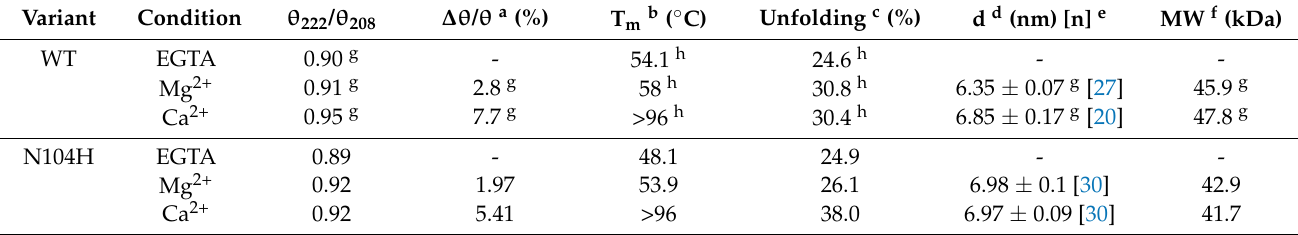
Table 2. Structural and stability descriptors extrapolated from CD spectroscopy, hydrodynamic diameter estimation by DLS, and apparent MW monitored by analytical SEC. a calculated as ( θ 222ion – θ 222EGTA )/ θ 222EGTA ; b melting temperature estimated by fitting ellipticity at 222 nm, as described in the Methods; c calculated as ( θ 22296 ◦ C – θ 22220 ◦ C )/ θ 22220 ◦ C ; d average hydrodynamic diameter ± s.e.m.; e number of measurements used for hydrodynamic diameter calculations; f apparent MW estimated by analytical gel filtration; g data were taken from Ref. [27]; h data were taken from Ref.